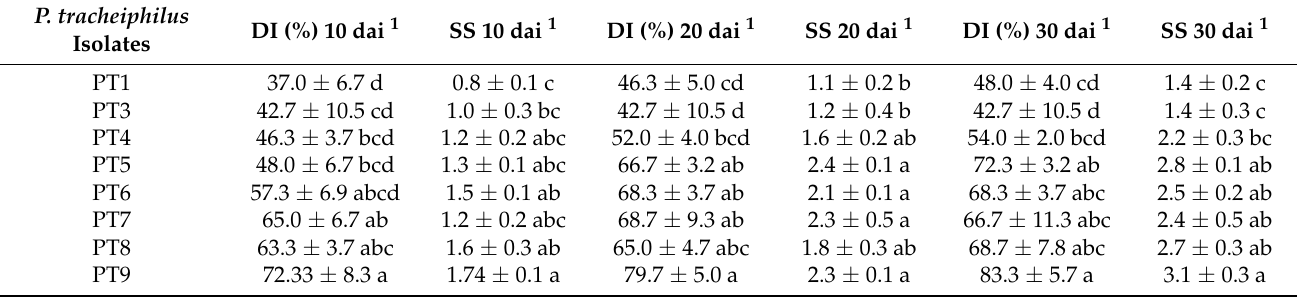
Table 4. Compared virulence of eight Plenodomus tracheiphilus isolates over